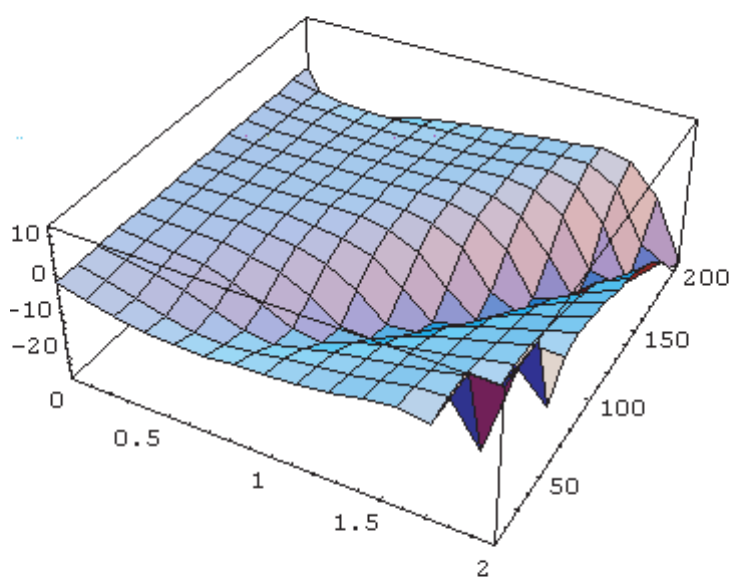
Fig. 4 Solution ˜ u 2 (27) for equation